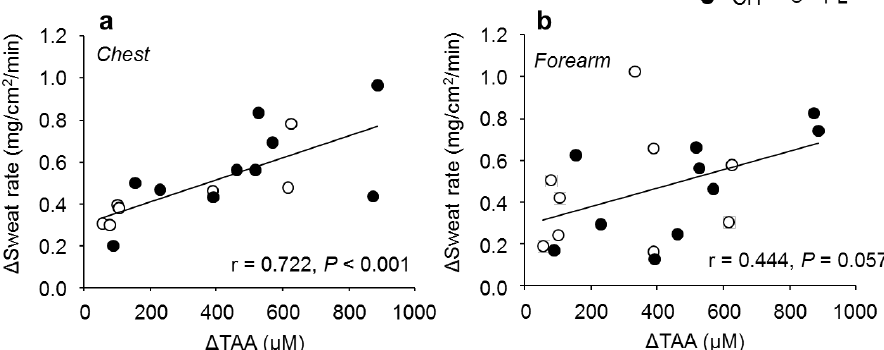
Figure 5. Relationship between changes in sweat rate (Δsweat rate) and plasma total amino acid (ΔTAA) concentration at 60 min after casein hydrolysate (CH) or placebo (PL) ingestion in the main experiment. Relationships ( a ) between Δsweat rate on the chest and ΔTAA ( n = 18), and ( b ) between Δsweat rate on the forearm and ΔTAA ( n = 19).